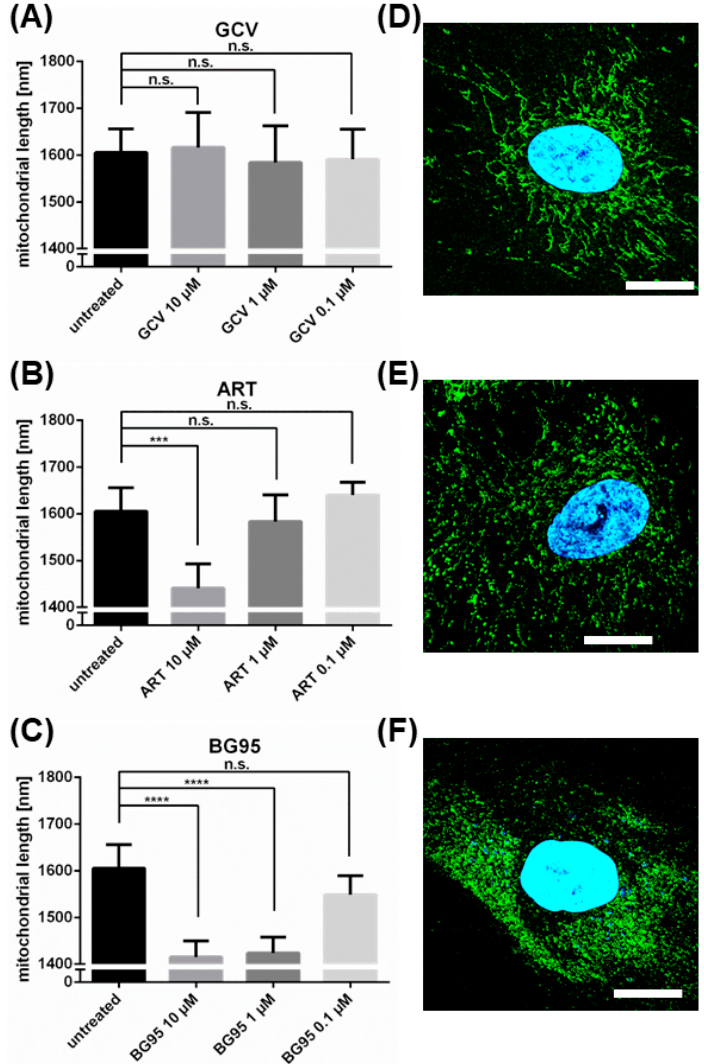
Figure 7. ART derivatives, but not control drug GCV, induce significant dose-dependent shortening of mitochondria in primary human fibroblasts. HFFs were treated with the indicated concentrations of compounds or remained untreated for 3 d, after which they were fixed and stained using DAPI and antibody against mitochondrial marker protein prohibitin. ( A ) Treatment with control drug GCV did not change mitochondrial architecture, as shown by no significant alteration to mean mitochondrial length. ( B ) Treatment with 10 µM of ART resulted in a statistically significant shortening of mitochondria. ( C ) Treatment with 10 µM as well as 1 µM of BG95 led to a highly significant shortening of mean mitochondrial length. The length of mitochondria was assessed using the FilamentDetector plugin of ImageJ. Mean mitochondrial length was measured in at least 5 individual images and >100 cells per compound/concentration. Data are given as the mean of mitochondrial length + SD. Statistical analysis was performed using ordinary One-way ANOVA followed by post-hoc Tukey’s test compared to untreated. **** p < 0.0001; *** p < 0.001; n.s., not significant (D-F) Representative confocal images of mitochondrial structure (green) in HFFs treated with GCV, ART or BG95, respectively (all 10 µM). Note in ( F ) the BG95 autofluorescence (blue) signal colocalized with mitochondria (green).